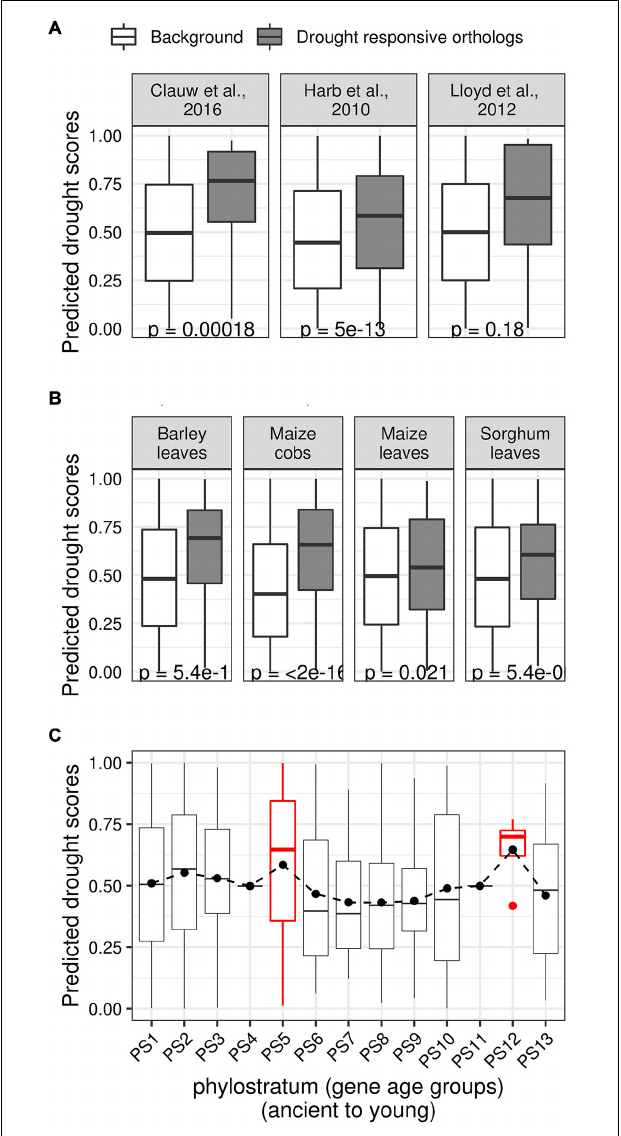
FIGURE 7 | Relationships between predicted drought scores and evolutionary features. (A) Three sets of putative drought regulators in Arabidopsis were curated from the literature, and their rice orthologs were identified. The three sets represent rice TFs with orthologs in Arabidopsis genes that were predicted as drought regulators (Clauw et al., 2016), that differentially expressed upon different drought treatment regimes (Harb et al., 2010), have been experimentally characterized as drought regulators (Lloyd and Meinke, 2012). The boxplots show the distribution of the predicted drought scores of these ortholog sets (gray) along with the drought scores of the background of remaining TFs (white; rice TFs that did not become part of the three ortholog sets). In each case, the median predicted drought scores of orthologous rice TFs was found to be significantly higher than the drought scores of the background. (B) Similarly, boxplots showing the distribution of drought scores of rice TFs with orthologs in genes that are differentially expressed in different crop datasets. (C) Box plot showing the distribution of drought scores in different age groups (ancient to young) according to NCBI taxonomic classification. The distribution of drought scores stays relatively flat, except for two peaks that correspond to the Embryophytes clade (PS5) and the Oryza clade